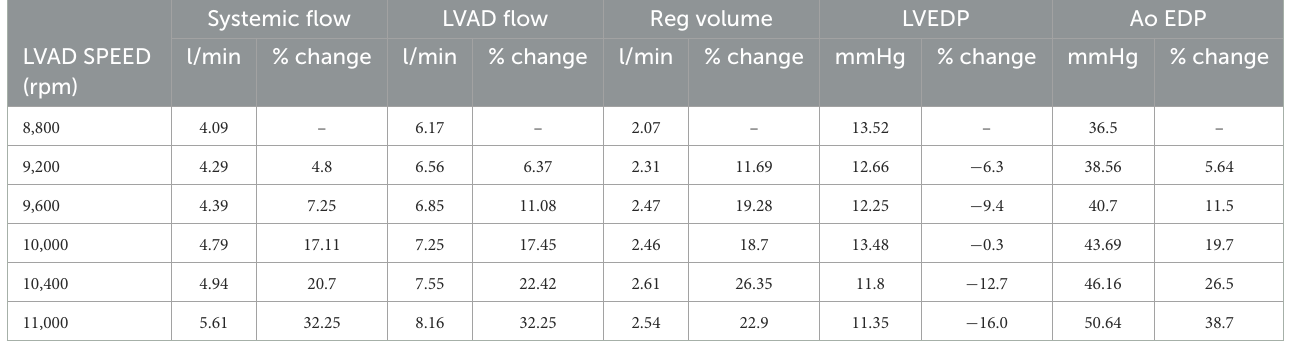
TABLE 1 Directly measured hemodynamic parameters within the flow loop at different LVAD speeds.